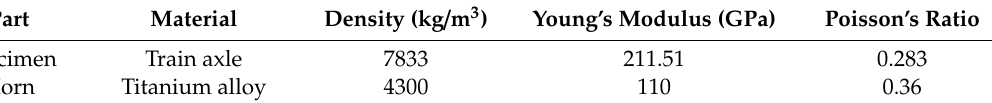
Table 2. Material properties used for the finite element simulation.